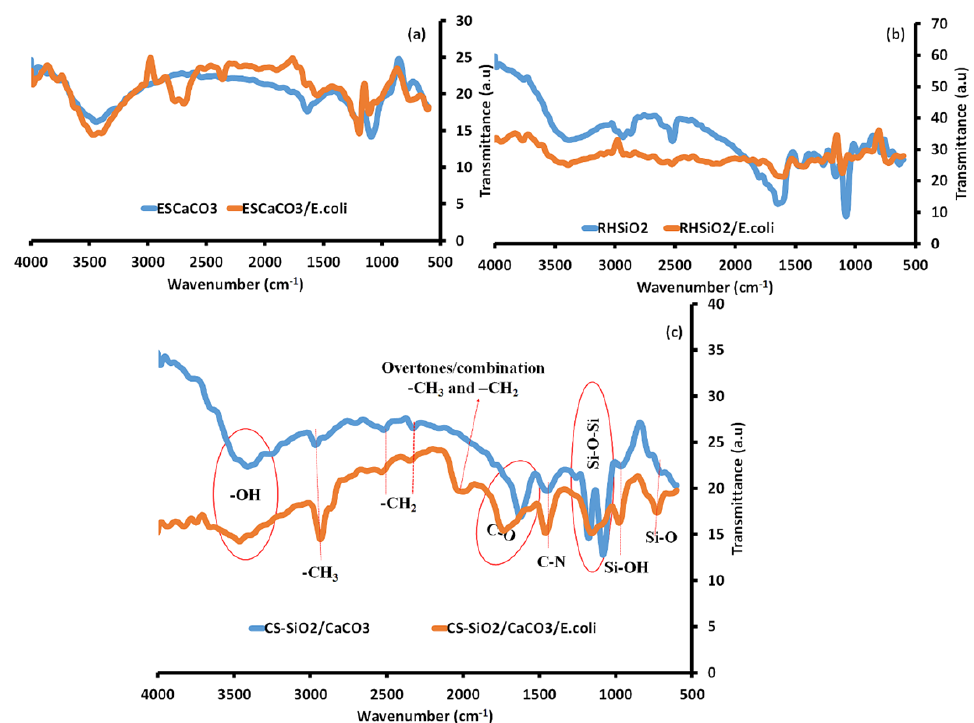
Figure 7. FTIR of ( a ) ESCaCO 3 NPs, ( b ) RHSiO 2 NPs, and ( c ) CS-SiO 2 /CaCO 3 NCs before and after treatment with E. coli .